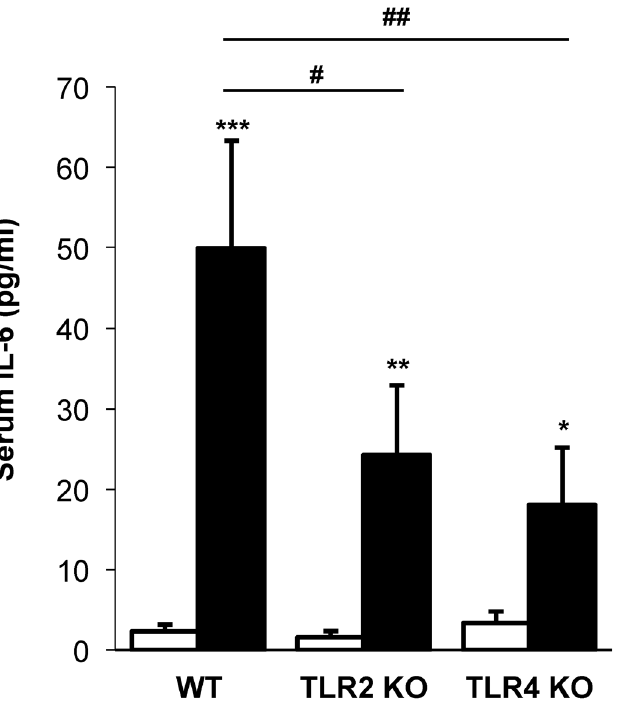
Fig 3. Repetitive inhalant ODE exposure-stimulated serum IL-6 levels are partially reduced in TLR2 and TLR4 KO mice. WT, TLR2 KO, and TLR4 KO mice were i . n . treated with ODE daily or saline for 3 weeks whereupon animals were euthanized 5 hrs following final exposure. Levels of IL-6 were determined in serum. Bar graphs represent the mean with standard error bars shown (N = minimum of 6 mice/group from 3 independent studies). Statistical significance denoted by asterisks ( * p < 0.05 ** p < 0.01, *** p < 0.001) as compared to respective saline treatment group. Line denotes statistical significance (#p < 0.05, ##p < 0.01) of WT vs. TLR2 and TLR4 KO